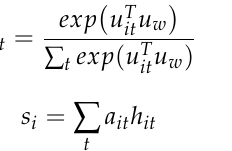
Figure 4. The structure and functionality of a hierarchical-attention network (HAN).